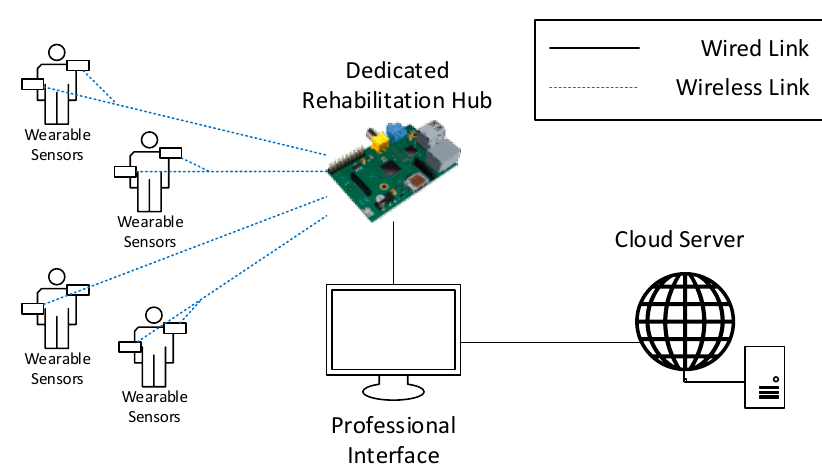
Figure 5. Example of deployment for the indoor group therapy use case.